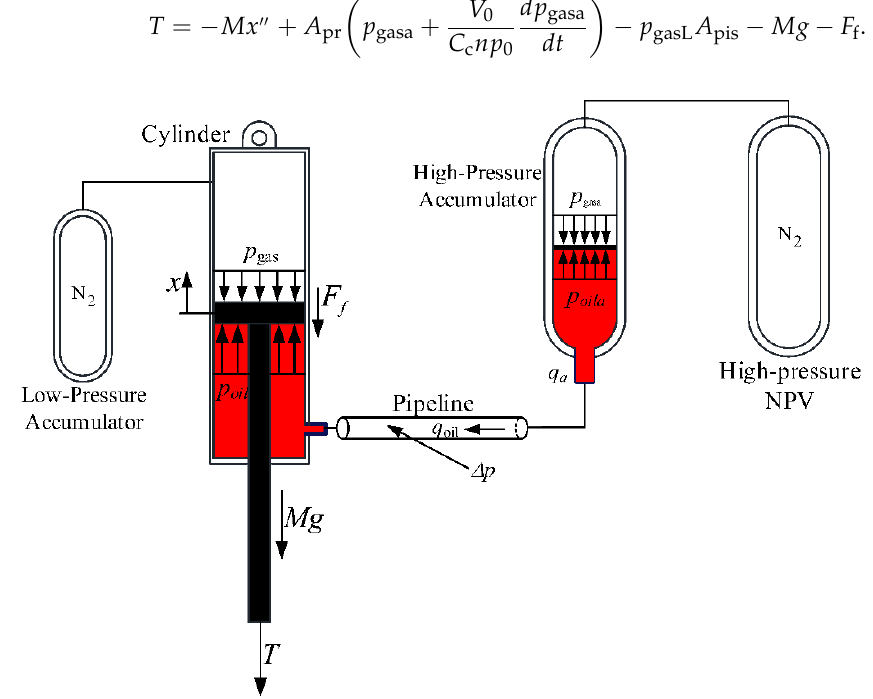
Figure 6. Schematic of the HPT.